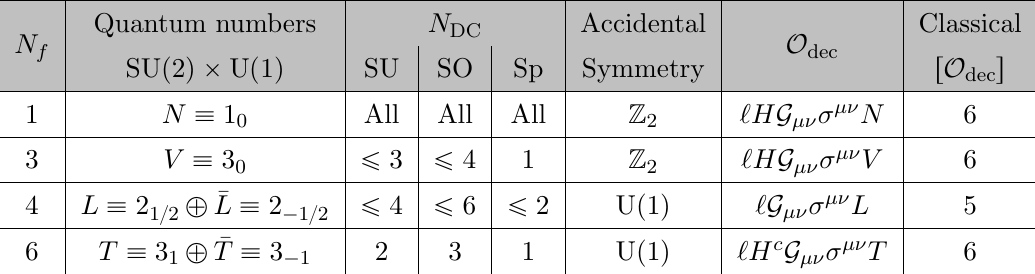
Table 1 . Minimal building blocks for models of gluequark DM. We require that a multiplet contains an electromagnetic neutral component and that the gauge couplings do not have Landau poles below 10 15 GeV, assuming a representative mass of 100 TeV for the dark quarks. We denote with ‘ the SM lepton